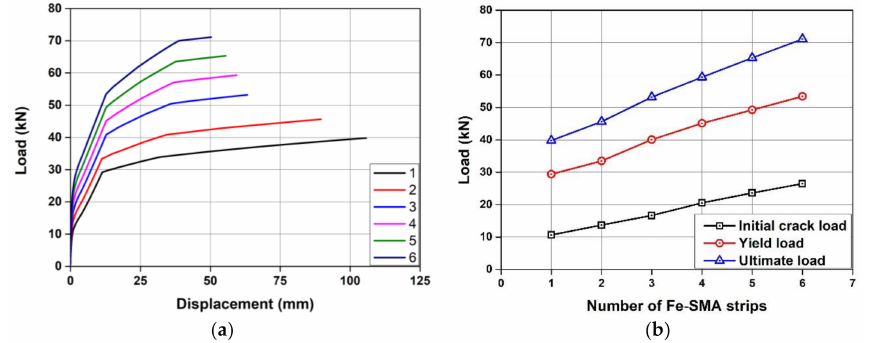
Figure 15. Effect of the number of Fe-SMA strips: ( a ) Comparison of load- displacement curves; ( b ) Comparison of load stages for the number of Fe-SMA strips.